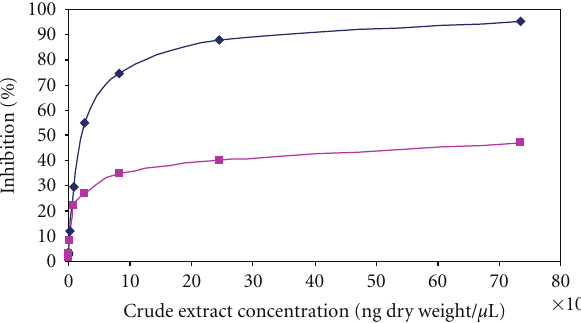
Figure 4: Dose-response curve of crude Balanite extract on P. falciparum M18 Aspartyl Aminopeptidase (PFM 18 AAP). Di ff erent concentrations of the crude Balanite extract ( µ g/mL) were applied in the in vitro activity assay of PFM 18AAP enzyme as described within the experimental section. The percentage of inhibition ( y - axis) was plotted versus the extract concentration ( x -axis). The blue curve represents the crude Balanite extract with 6-phenyl-2(H)- 1,2,4-triazin-5-one oxime while the pink curve shows the depleted extract where the compound is